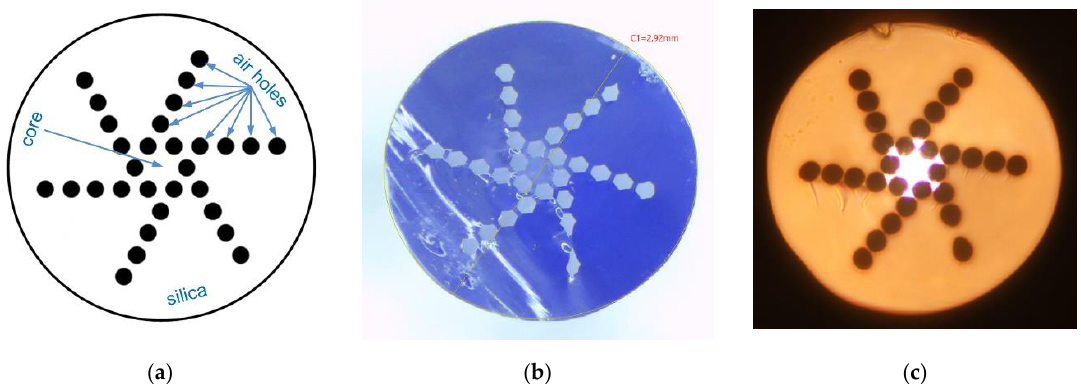
Figure 3. ESSR-MOF: ( a ) cross-section sketch; ( b ) MOF prepared cane (outer diameter 3 mm); ( c ) image of fabricated ESSR-MOF end (outer diameter 125 µm).